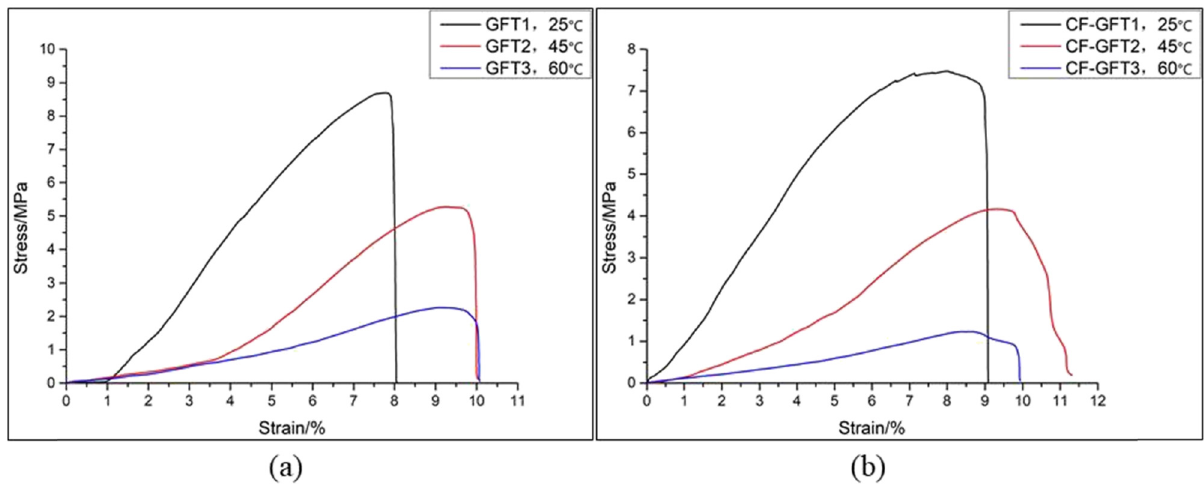
Figure 7: Stress – strain curves of 2D braided composites at di ff erent temperatures: ( a ) pure glass fi ber braided composites and ( b ) carbon fi ber - glass fi ber hybrid braided composites.